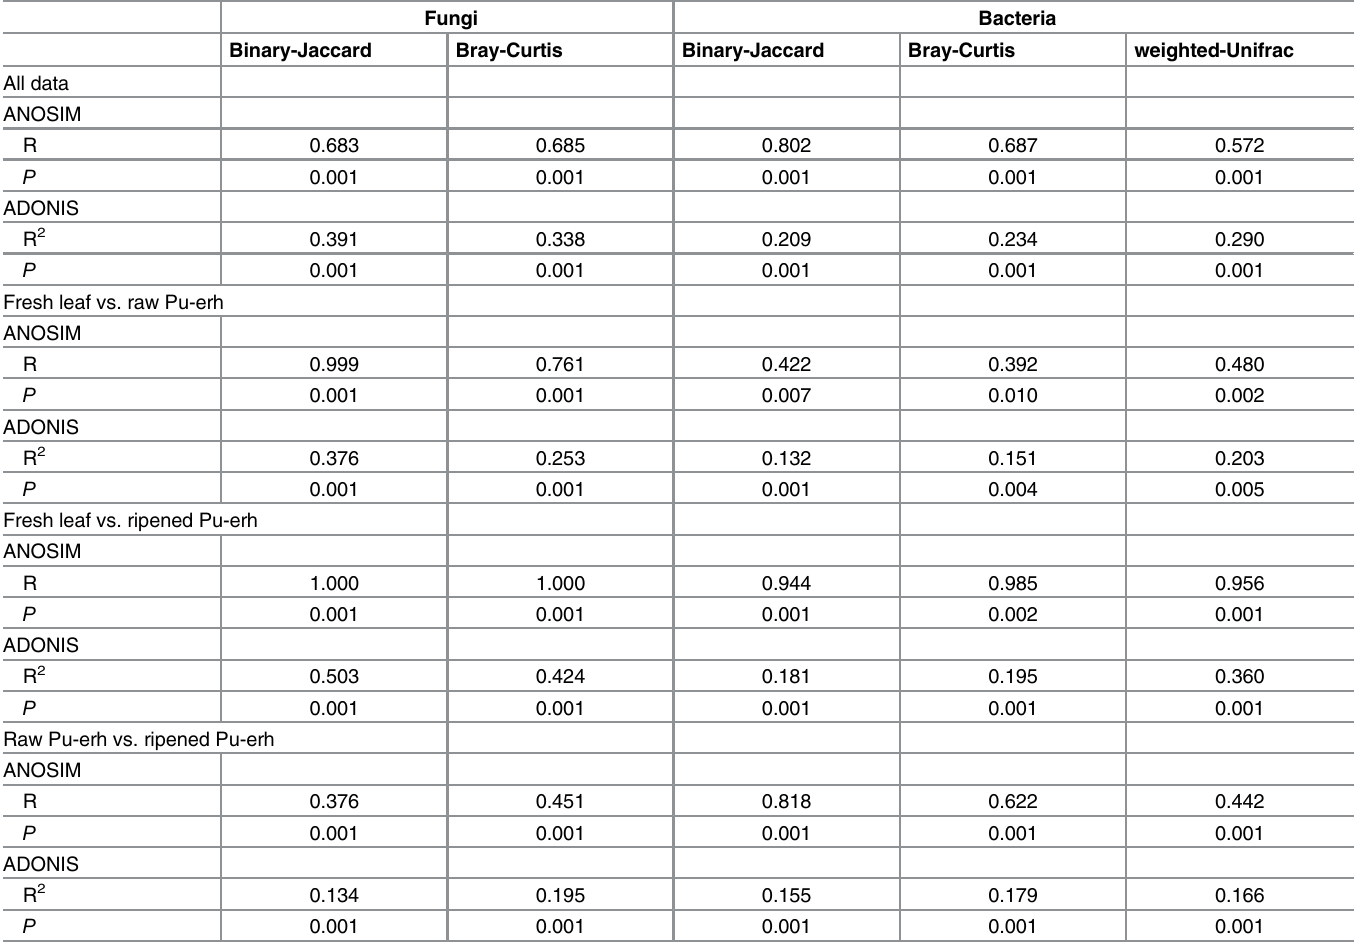
Table 1. Comparison among fresh leaf, raw Pu-erh and ripened Pu-erh samples at β -diversity